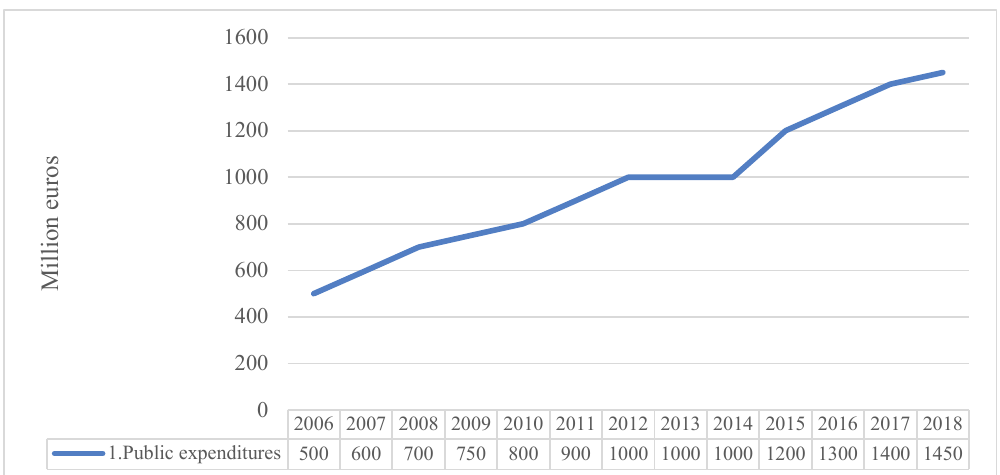
Fig. 4. Performance of indirect taxes in the Republic of Kosovo in 2006–2018 (Budget of the Republic of Kosovo, Ministry of Finance (MoF). Annual Financial Report of 2006–2018).